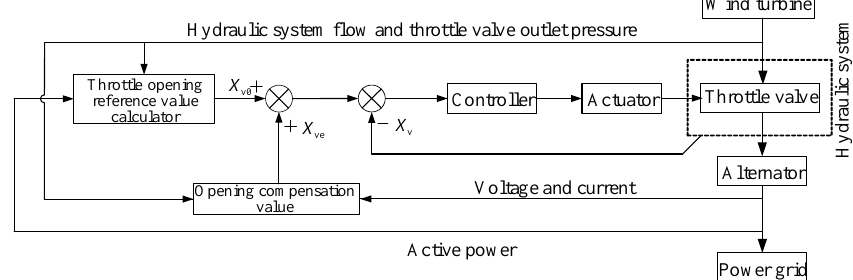
Figure 7. Block diagram of proportional throttle valve dissipation opening reference value.